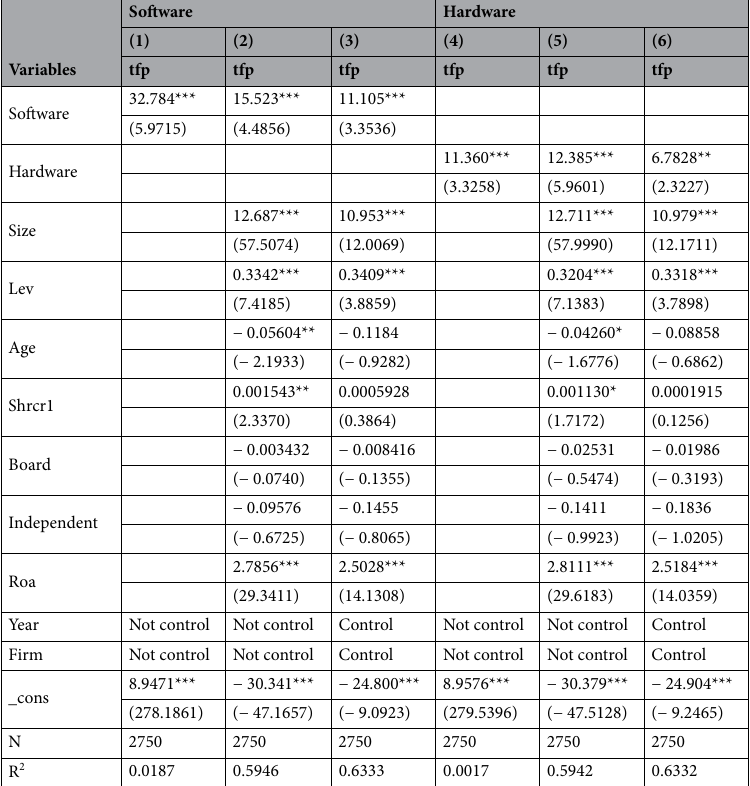
Table 7. Regression results with replacement of explanatory variables. T-statistics are shown in parentheses. ***, ** and * indicate 1%, 5% and 10%